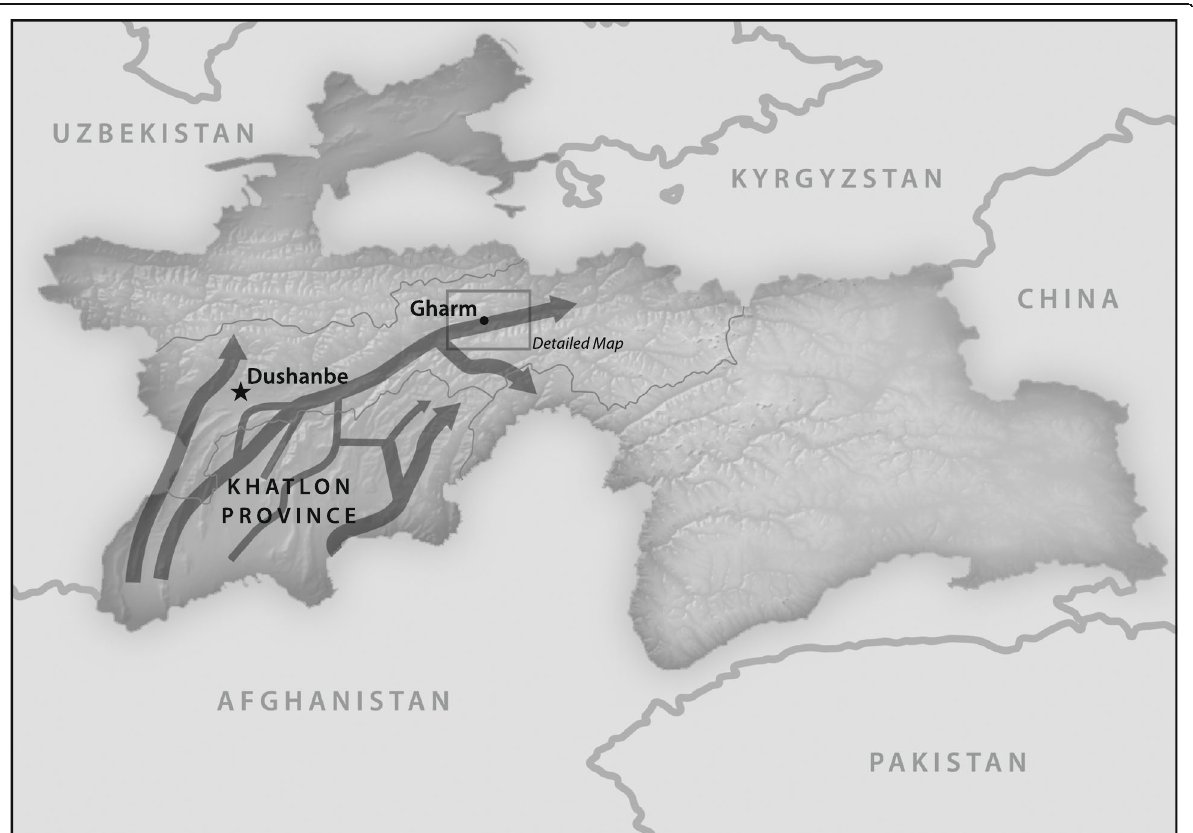
Fig. 1 Map of Tajikistan. Arrows show general patterns of long-distance transhumance routes to summer pastures, including those used by non- local herders in the study